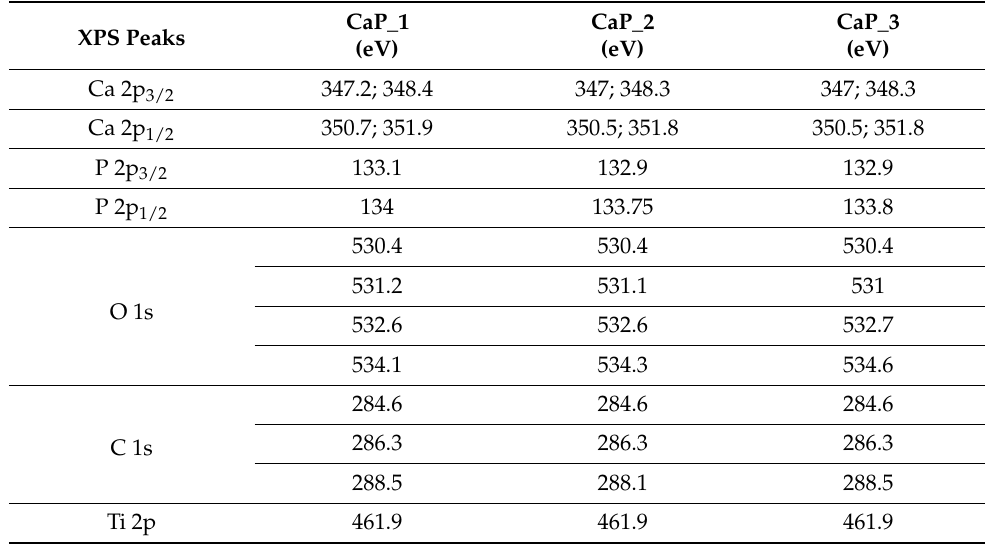
Table 1. Table 1. XPS binding energies (eV) for the CaP coatings. XPS Peaks